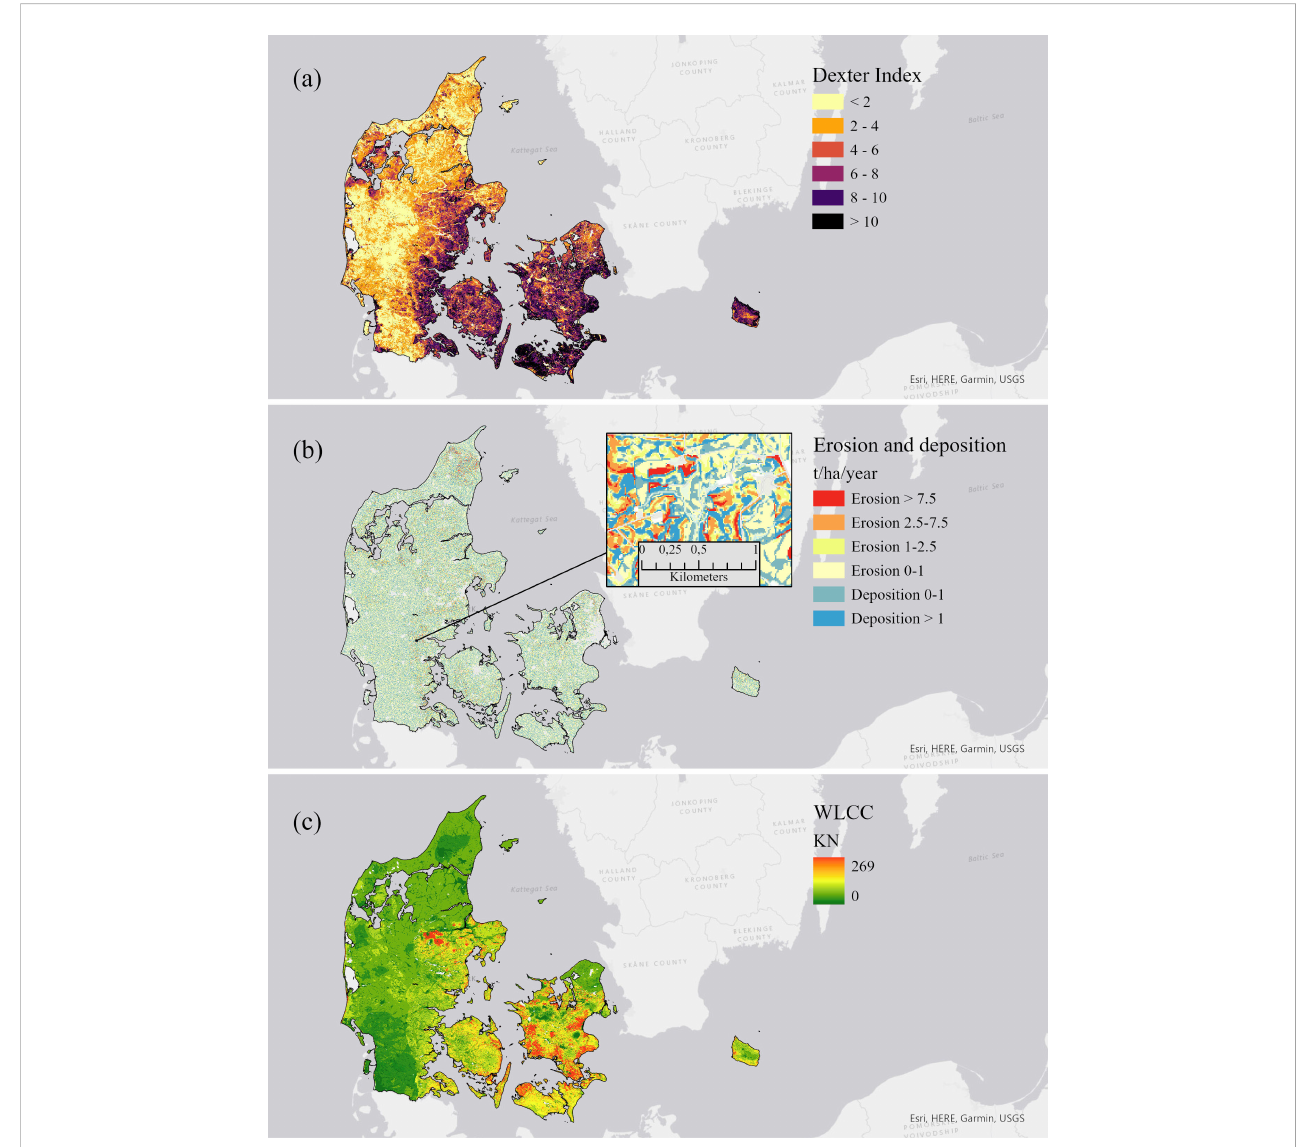
FIGURE 9 Main soil threats in Denmark represented by (A) Dexter index, (B) water erosion risk, and (C) risk of soil compaction as the maximum load that can be carried by a given tyre without compaction at 0.35 m depth (i.e., wheel load carrying capacity or WLCC, in